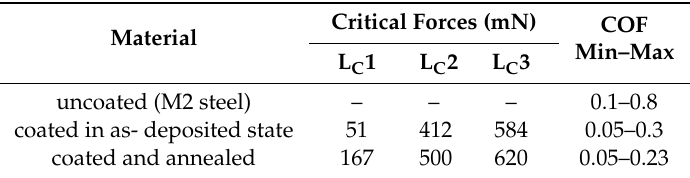
Table 3. Coe ffi cients of friction COFs for coated and uncoated steel samples examined in the scratch-test with diamond and critical forces Lc for the coated M2 steel in as-deposited state and after